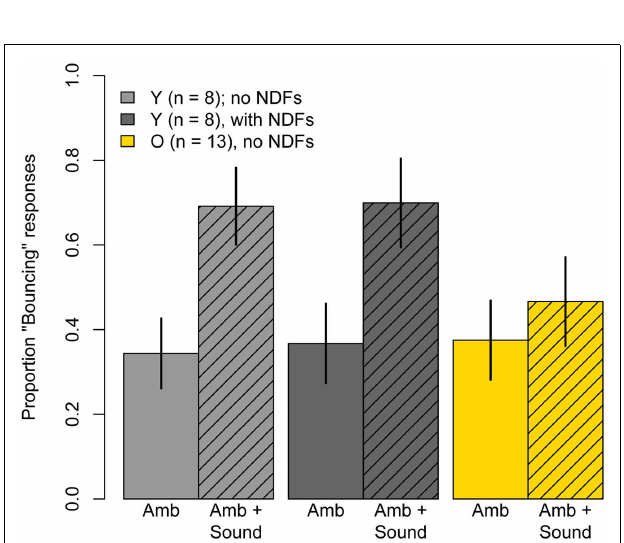
FIGURE 6 | Mean Pr(“Bouncing”) responses produced in the ambiguous conditions of ExperimentTwo: Ambiguous motion and Ambiguous motion accompanied by the sound used in Experiment One . Light gray bars represent data for eight younger subjects when they viewed the stimuli normally, without neutral density filters, and the dark gray bars represent results obtained when subjects viewed the stimuli through three neutral density filters.Yellow bars represent data of 13 older subjects who participated in Experiment One and were retested in these conditions without neutral density filters. Error bars are ± 1 standard error of the